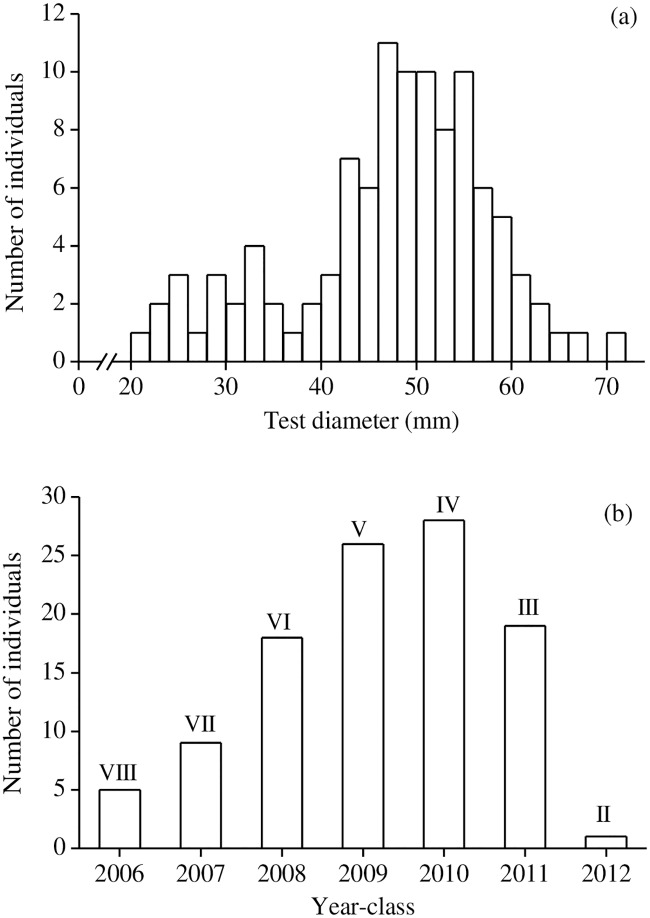
Size-frequency distribution (a) and year class composition (b) of Heliocidaris crassispina collected in August 2014.Roman numerals indicate ages.